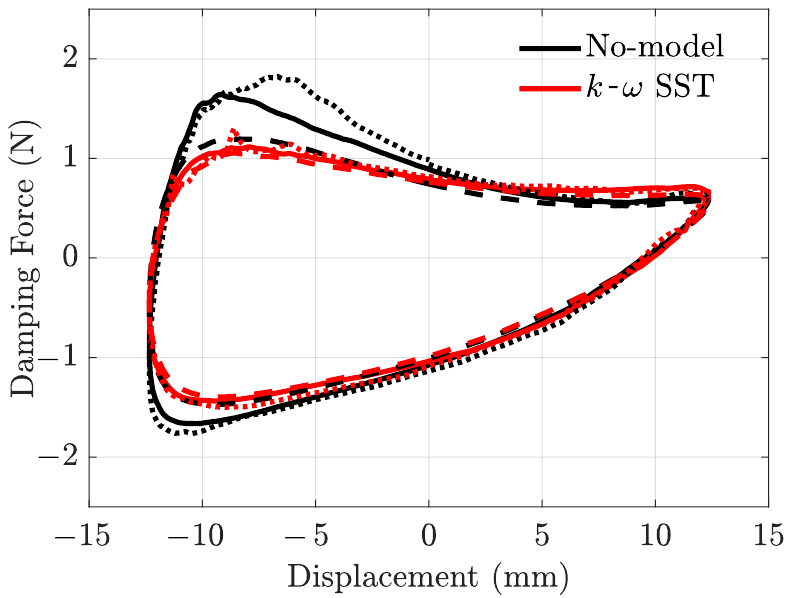
Figure 2. Illustration of the mesh resolution on the damping force as a function of the displacement obtained by no-model and k - ω SST simulations. The dashed, solid and dotted lines correspond to Mesh-1, Mesh-2 and Mesh-3,